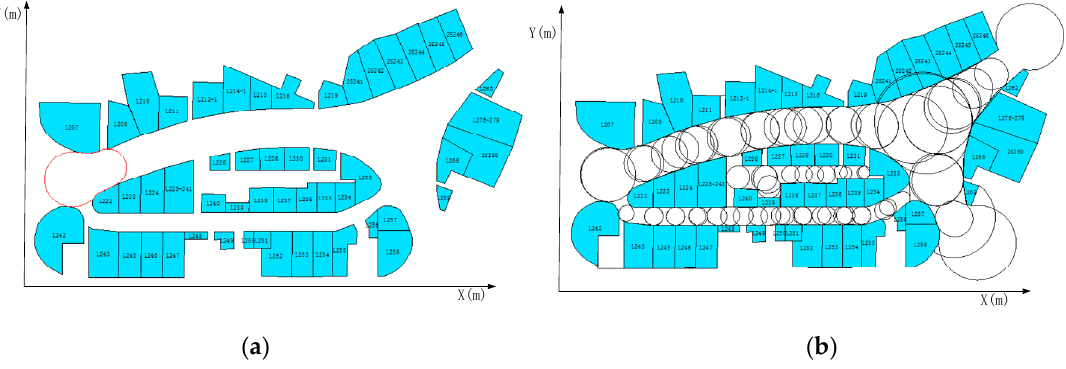
Figure 8. ( a ) The near boundary of L207 , ( b ) The near boundaries of the ROs.